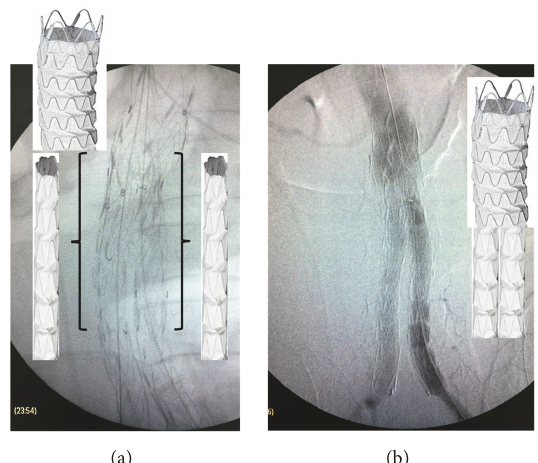
Figure 5: (a) Two Ankura limbs, 16-16 × 100, were simultaneously deployed as parallel kissing endografts. The proximal 6cm of the parallel endografts was positioned above the Talent bifurcation within the Ankura cuff and the distal 4 cm inside each Talent limb. (b) Completion of angiogram verified endoleak resolution, renal and iliac artery patency, and proper endograft